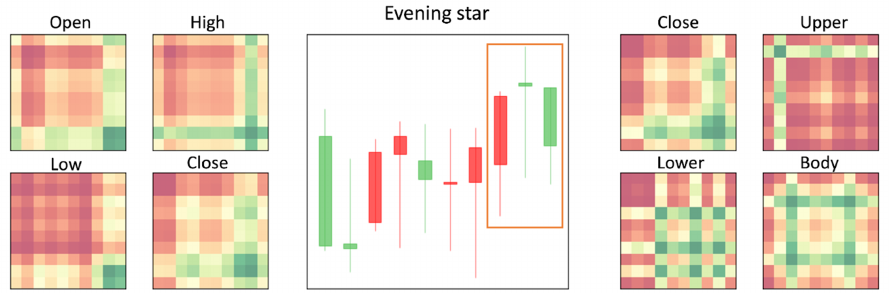
Figure 12. Example of Evening Star pattern and GASFs. The middlemost figure is the original candlesticks. The red and green candlesticks represent closing prices are higher than the opening prices are not. The left and right sides are the heatmaps of GASFs. The range of the heatmap is ( − 1,1 ) , where red equals − 1 and green equals 1.